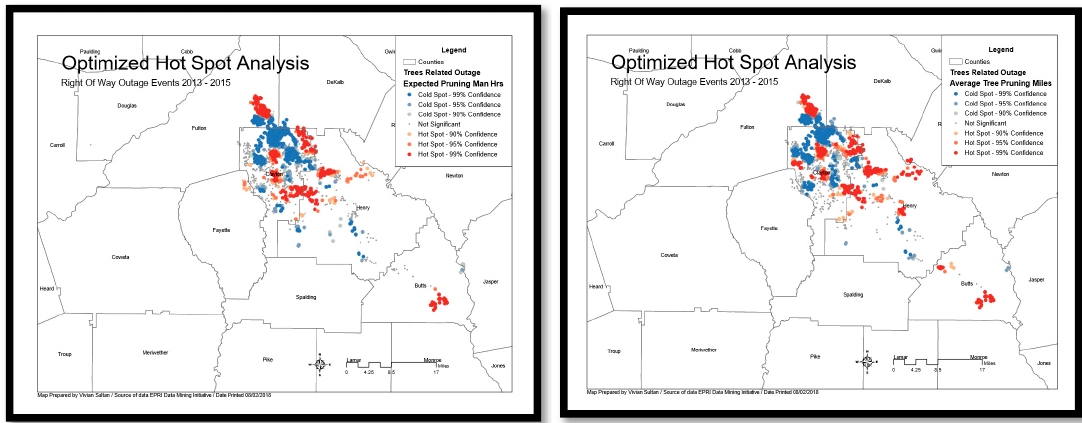
Figure 16. Spatial Analysis Level 3—Optimized Hot Spot Analysis output maps for right of way outage events. left : Expected Pruning Staff Hours; right : Average Standard Tree Pruning Miles with Bucket; bottom: Actual Pruning Staff Hours/Circuit Mileage.